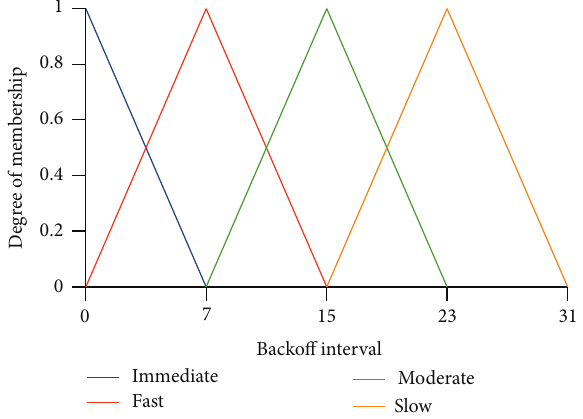
Figure 4: Membership diagram of output parameter backoff inter- val assuming that CW = 31 .